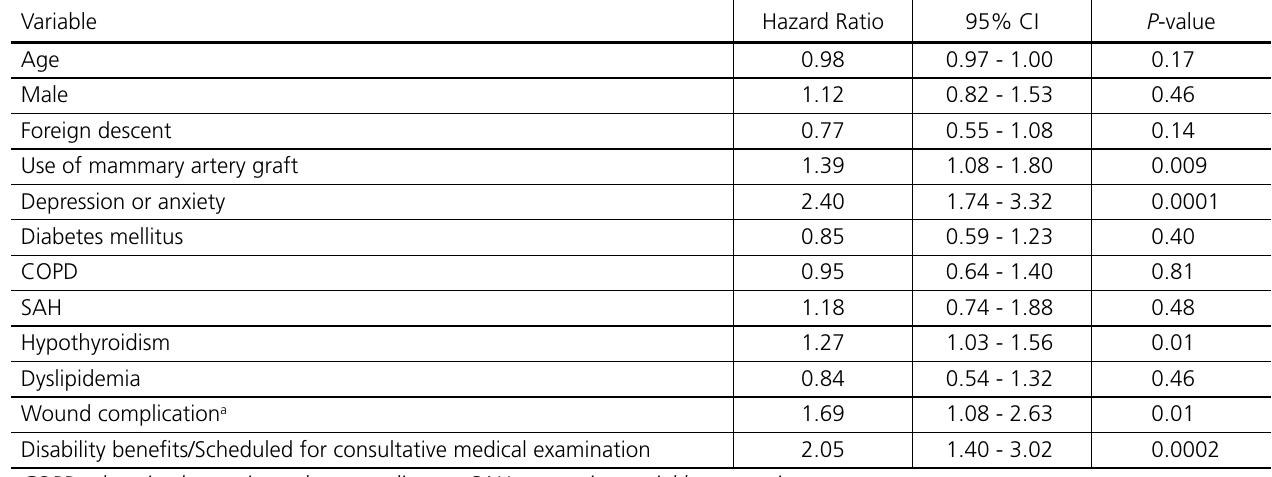
Table 3. Statistical analysis using Cox’s regression